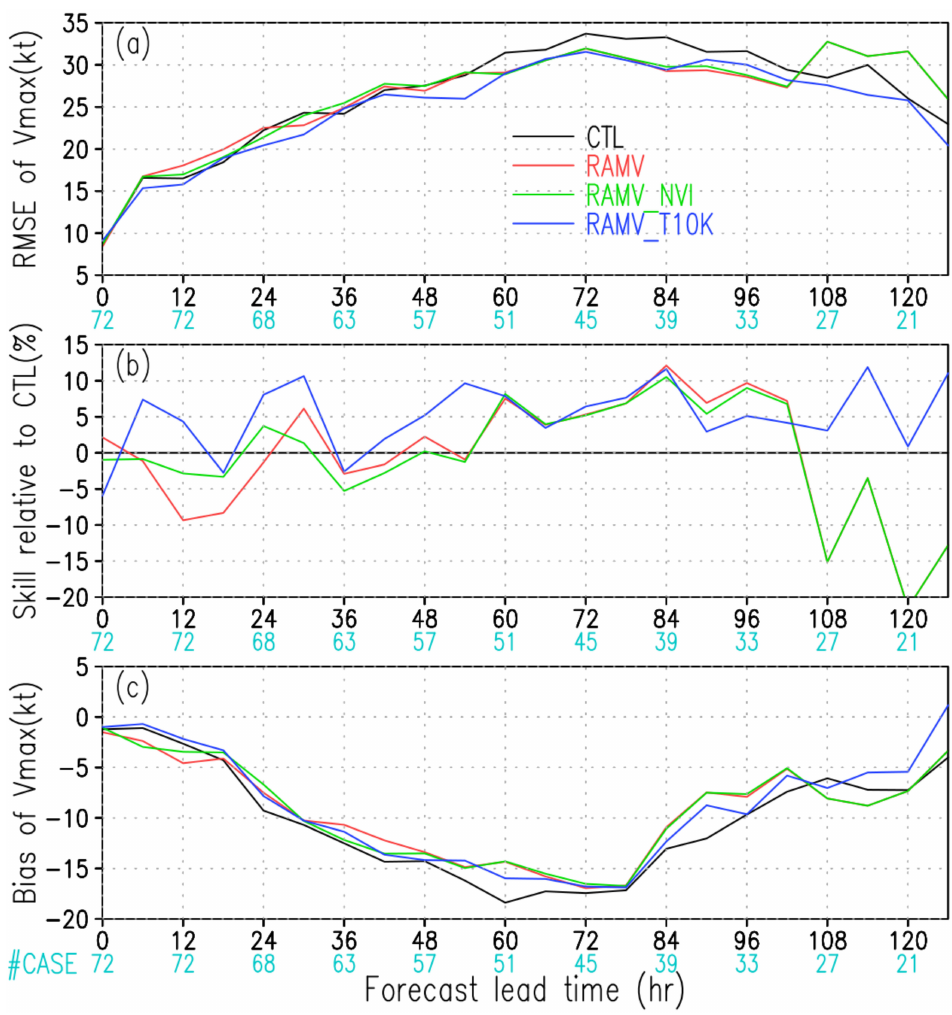
Figure 3. As in Figure 2, but for ( a ) RMSE, ( b ) skill, and ( c ) bias of